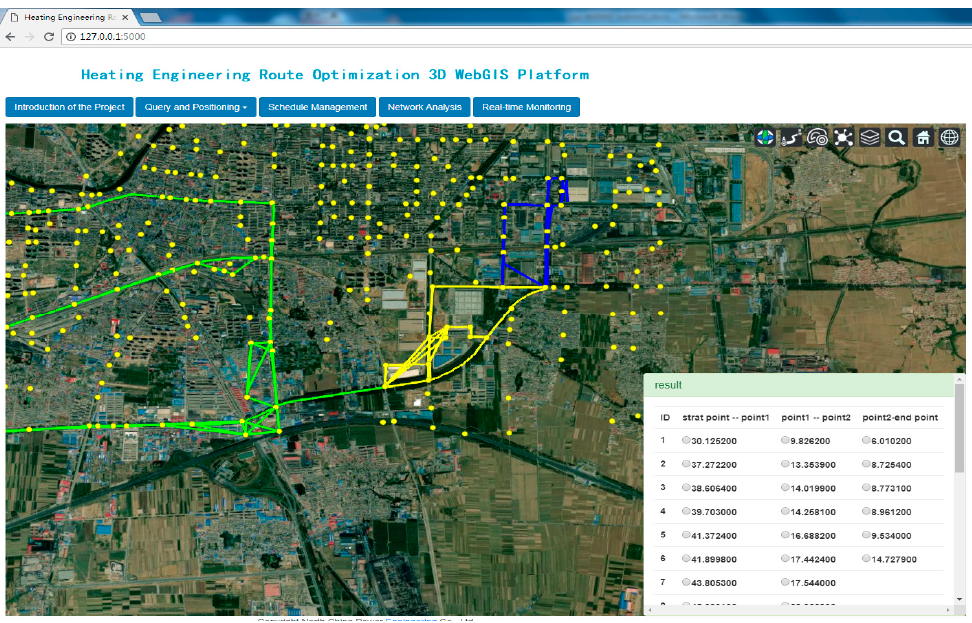
Figure 7. Scheme comparison interface with alternative routes of the three sub zones (green ones for the first zone, yellow ones for the second zone, and blue ones for the third zone).